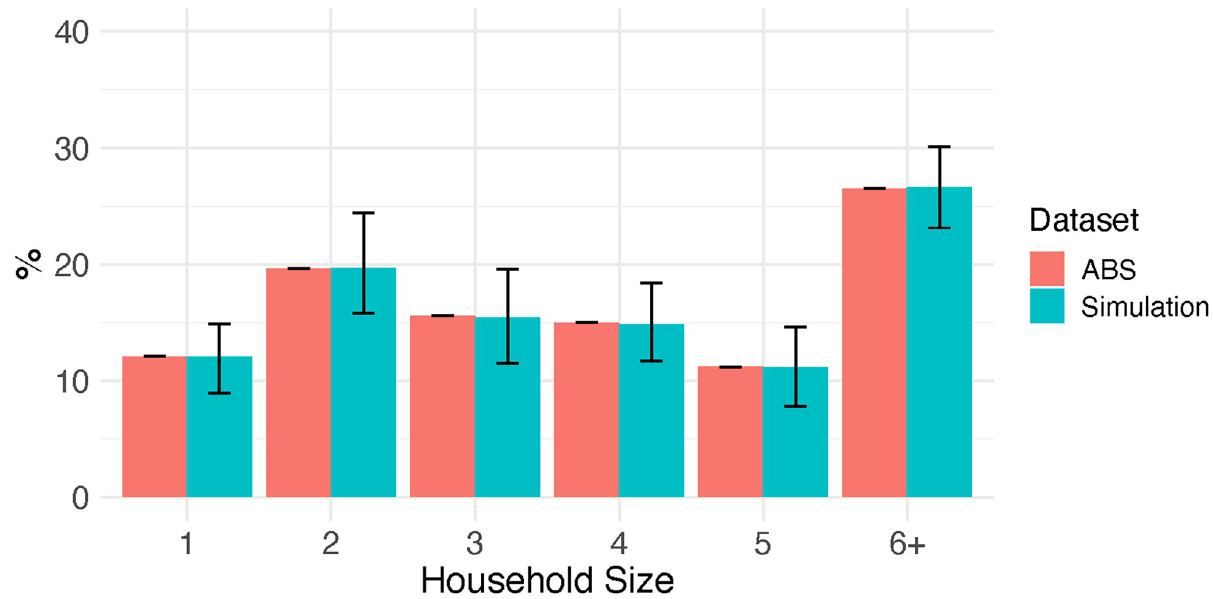
Fig 1. Household size distribution. Household size distribution (median and 2.5–97.5 quantiles) of simulated data (blue) and Indigenous communities household size distribution taken from Australian Bureau of Statistics 2016 census data (red) [37] are presented.